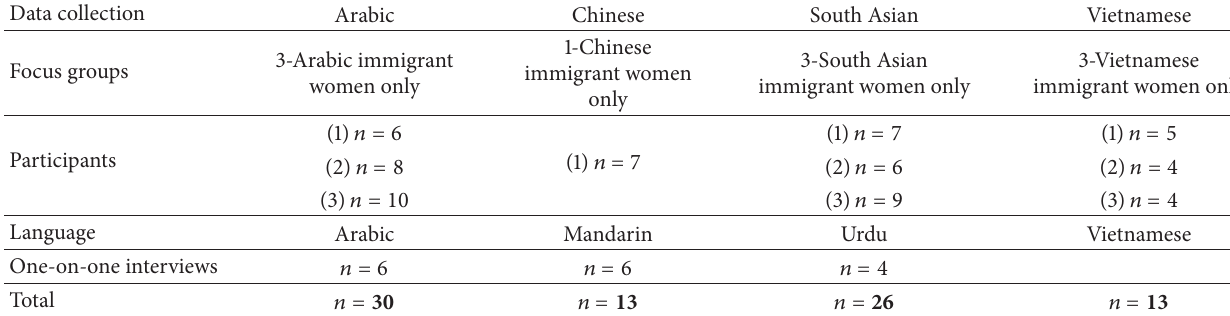
Table 1: Focus group